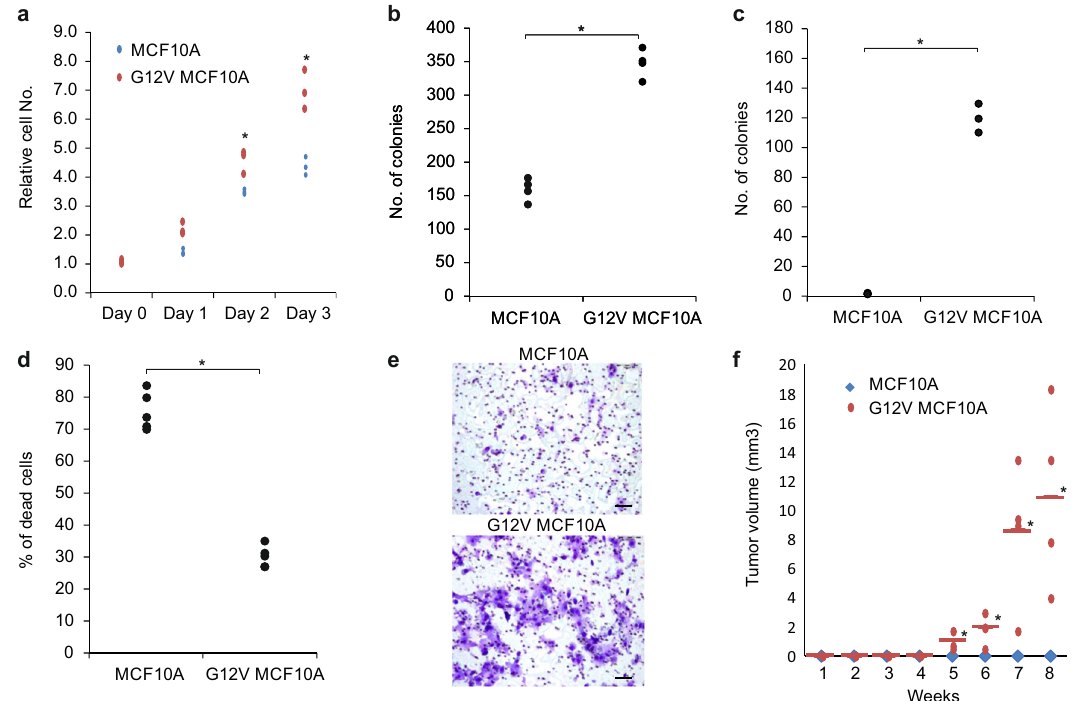
Fig. 1 Characterization of G12V cells. a Cell proliferation was measured by XTT assay. The relative number of cells, compared to day 0 is presented for MCF10A (blue line) and G12V cells (red line). b Cell survival was measured by colony formation assay. The number of colonies counted after 2 weeks of MCF10A and G12V cells are presented. c Anchorage-independent growth was measured by soft agar assay. The number of colonies formed for MCF10A and G12V cells is presented. d Resistance to anoikis was measured by anchorage-independent cell death assay. The percentage of cell death for MCF10A and G12V cells is presented. e Representative images of Boyden Chamber Matrigel invasion assay of MCF10A and G12V MCF10A cells (bar = 50 µ m) . f Tumor growth curve of mammary fat pad tumors in Nod-SCID mice injected with either MCF10A or G12V cells. Horizontal bars represent average. *indicates p < 0.05 T -test of at least three independent